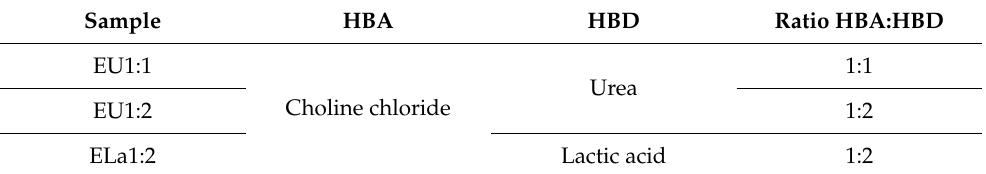
Table 1. Conditions of the cellulose extraction from sugarcane bagasse using deep eutectic solvents. Sample